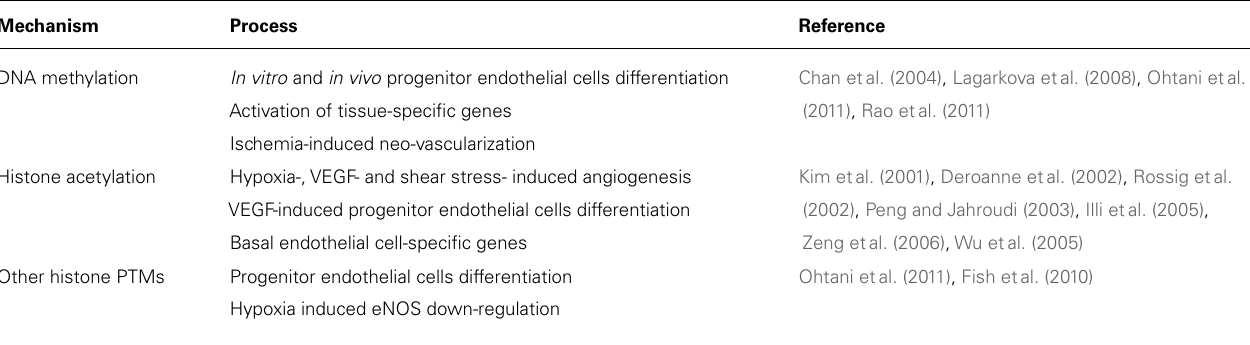
Table 1 | Effect of DNA methylation and histone post-translational modifications (PTMs) on endothelial cell physiology.